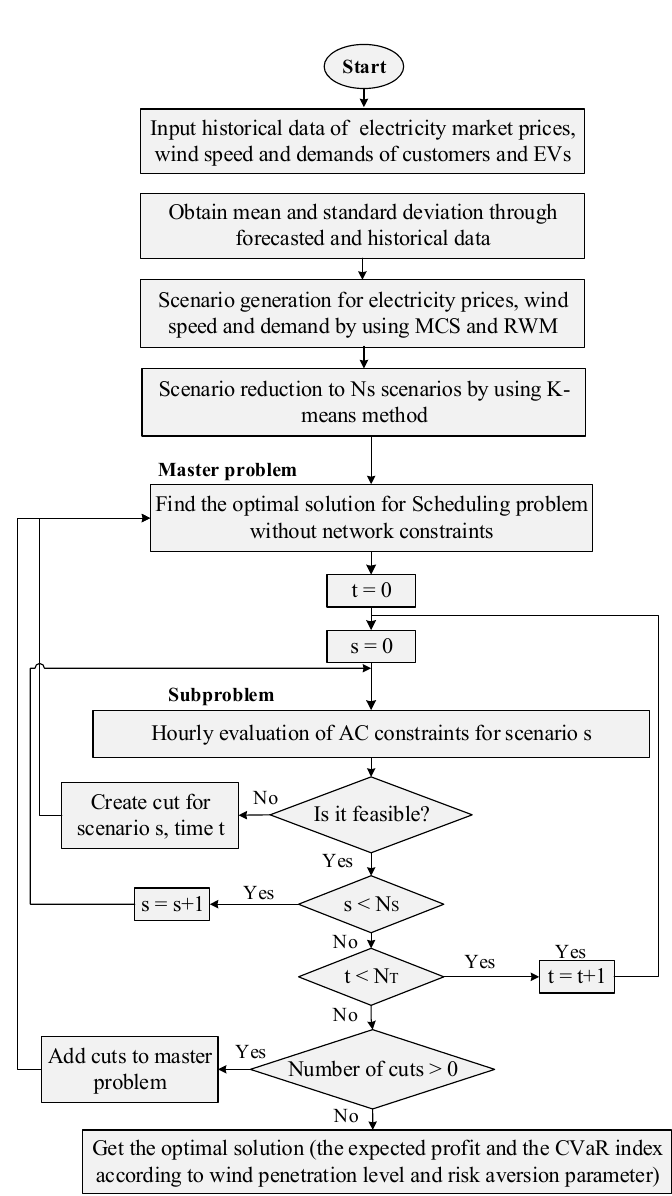
Figure 1. Flowchart of the proposed algorithm for solving the optimal scheduling model.